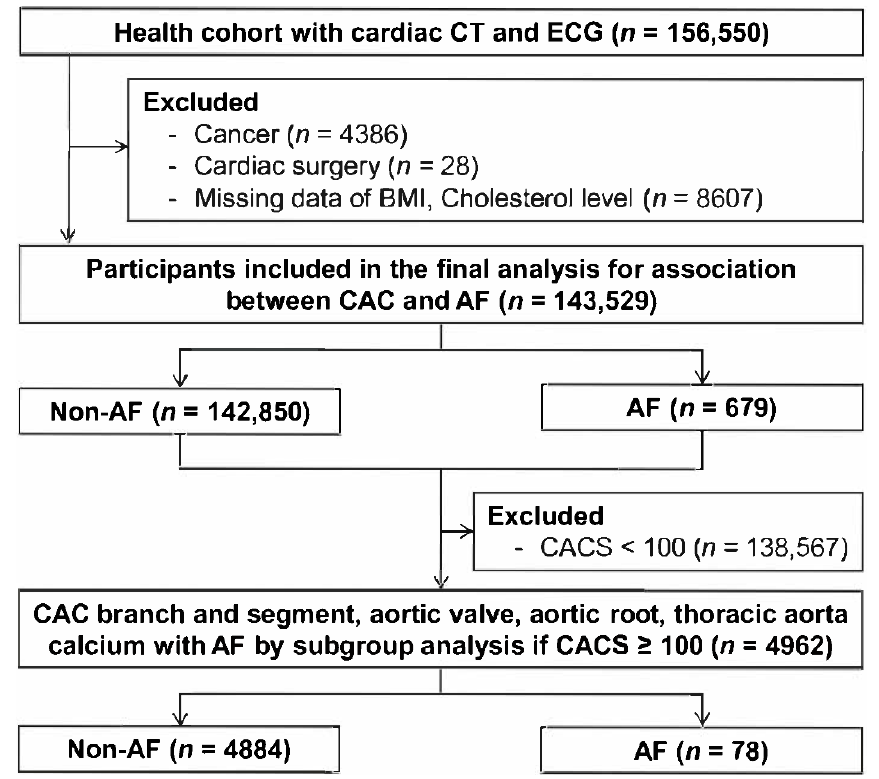
Figure 1. Flowchart of the study population. Abbreviations: ECG = electrocardiography; BMI = body mass index; AF = atrial fibrillation; CAC = coronary artery calcium; CACS = coronary artery calcium score.